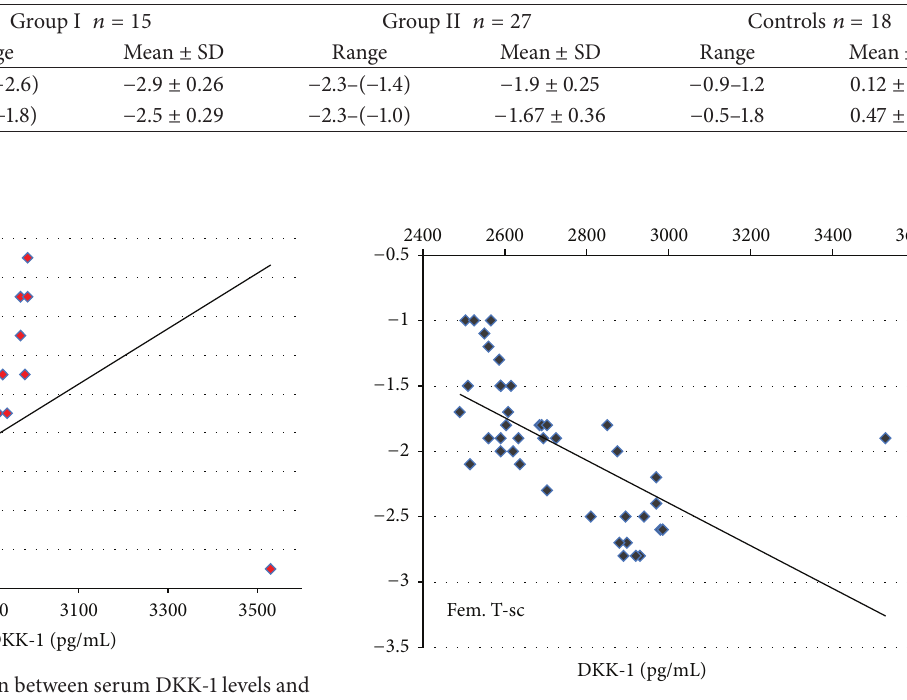
Figure 3: The negative correlation between serum DKK-1 levels and femur 𝑇 score in both group I and group